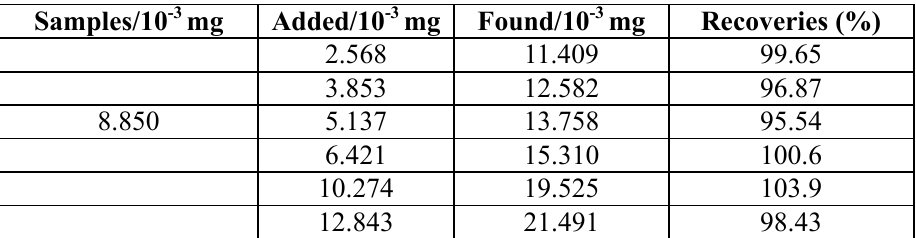
Table 1. Result of recoveries of